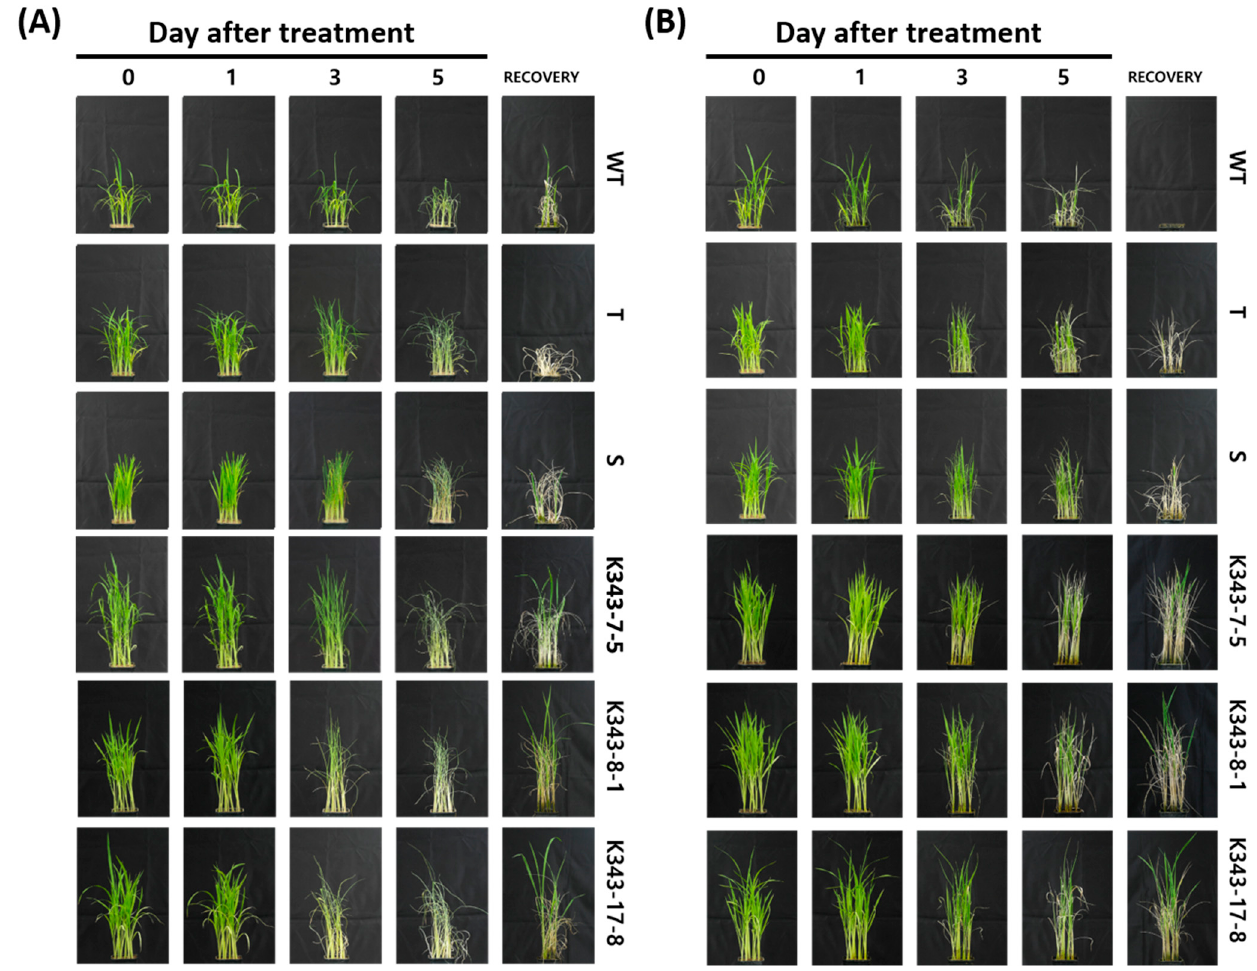
Figure 6. Phenotype of responses induced by drought and salinity stress treatment in T 2 PUB7-GE. ( A ) Phenotype of PUB7-GE in the presence of 5% soil moisture content. WT, Dongjin; T, Sangnambat; S, Gaya. ( B ) Phenotype of PUB7-GE in the presence of 250 mM NaCl. WT, Dongjin; T, Cheongho; S, Nampyeong.